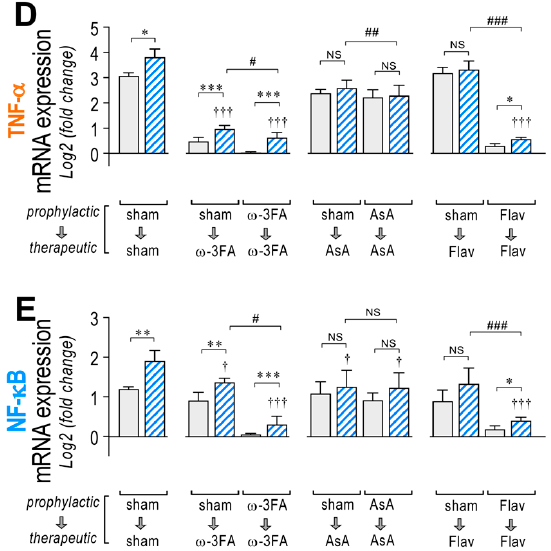
Figure 4. VE-Cadherin, α -SMA, Col III, TNF- α , and NF- κ B mRNA expression through dietary supplementation based on ω -3 FA, ascorbic acid, or polyphenolic antioxidant flavonoids in survivor and non-survivor endotoxemic rats. After endotoxemia treatment supplemented with water (sham), ω -3 fatty acid ( ω -3 FA), ascorbic acid (AsA), or polyphenolic antioxidant flavonoids (Flav), through a therapeutic and a prophylactic protocol, the mRNA expression of VE-Cadherin ( A ), α -SMA ( B ), Col III ( C ), TNF- α ( D ), and NF- κ B ( E ) were determined in survivor (grey bars) and non-survivor (dashed bars) endotoxemic rats. Statistical differences were assessed by two-way ANOVA followed by Dunnett’s post hoc test. * p < 0.05; ** p < 0.01; *** p < 0.001 comparing saline and endotoxemia